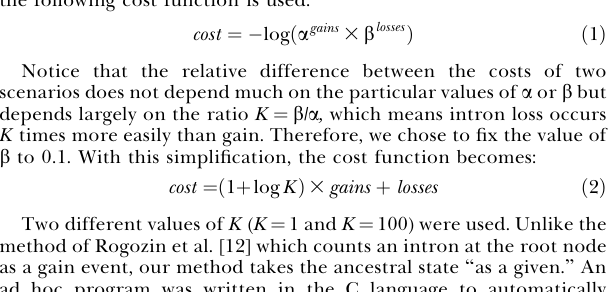
Dataset S1. Matrix of the Entire Set of Intron Presences and Absences Figure S1. Alignments of Amino Acid Sequences and Intron Positions MRP homologs are indicated with light grey shading. Conserved amino acids are highlighted by a dark grey background. Phase 0, 1, and 2 intron positions are highlighted by red, blue, and green backgrounds, respectively. At, A. thaliana; Ce, Ca. elegans; Ci, Ci. intestinalis; Dd, Di. discoideum; Dm, Dr. melanogaster; Ec, E. coli; Hs, H. sapiens; Ol, O. laptides; Pf, P. falciparum; Rp, R. prowazekii; Sp, S. pombe . Found at DOI: 10.1371/journal.pgen.0020025.sg001 (243 KB PDF). Figure S2. Alignments of 20-bp Sequences Flanking the Intron Positions Shared by the Genes Encoding CRPs and MRPs SplicesitesthatarecompletelyconsistentwiththeMAG j Rsequenceare shown in red. Conserved nucleotides between CRP and MRP genes are highlighted by a grey background. þ indicates the presence of intron. At, A. thaliana; Ce, Ca. elegans; Ci, Ci. intestinalis; Dd, Di. discoideum; Dm, Dr. melanogaster; Hs, H. sapiens; Ol, O. laptides; Pf, P. falciparum; Sp, S. pombe . Found at DOI: 10.1371/journal.pgen.0020025.sg002 (47 KB PDF). Table S1. List of CRP and MRP Homologs *For O. laptides and Ci. intestinalis, the scaffold number was shown. For Di. discoideum, the dictyBaseID was shown. (cid:1) For genes with multiple copies, only one copy was used. When the number of introns in multiple copies of the same gene was different, the one with the most introns was used. z Gene structures were determined by a combination of these sequences. §Gene sequences were